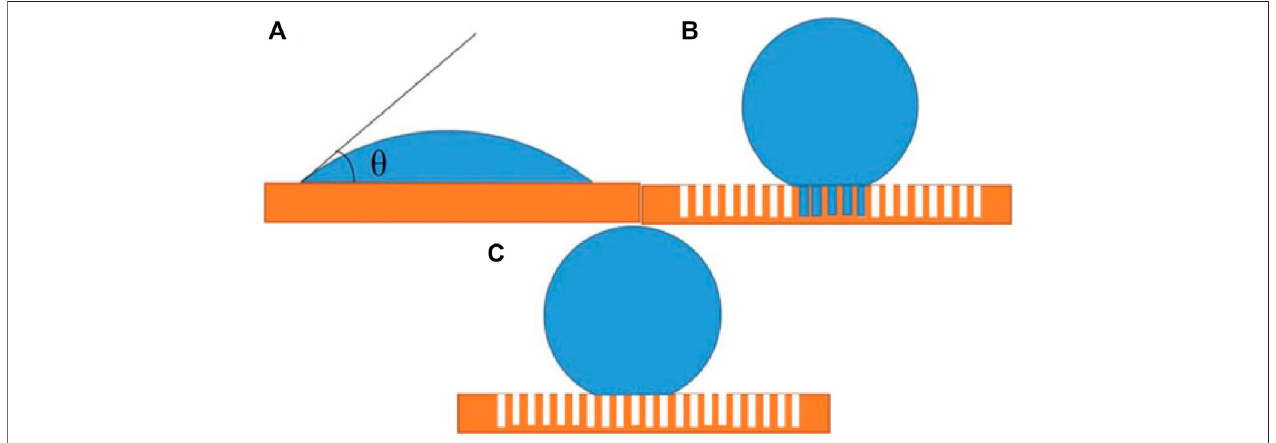
FIGURE 5 | (A) Young ’ s model. (B) Wenzel model. (C) Cassie and Baxter